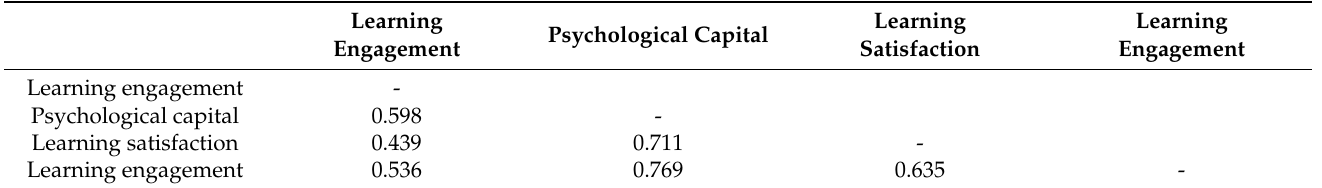
Table 1. The HTMT between emotion regulation, psychological capital, learning satisfaction, and learning engagement.